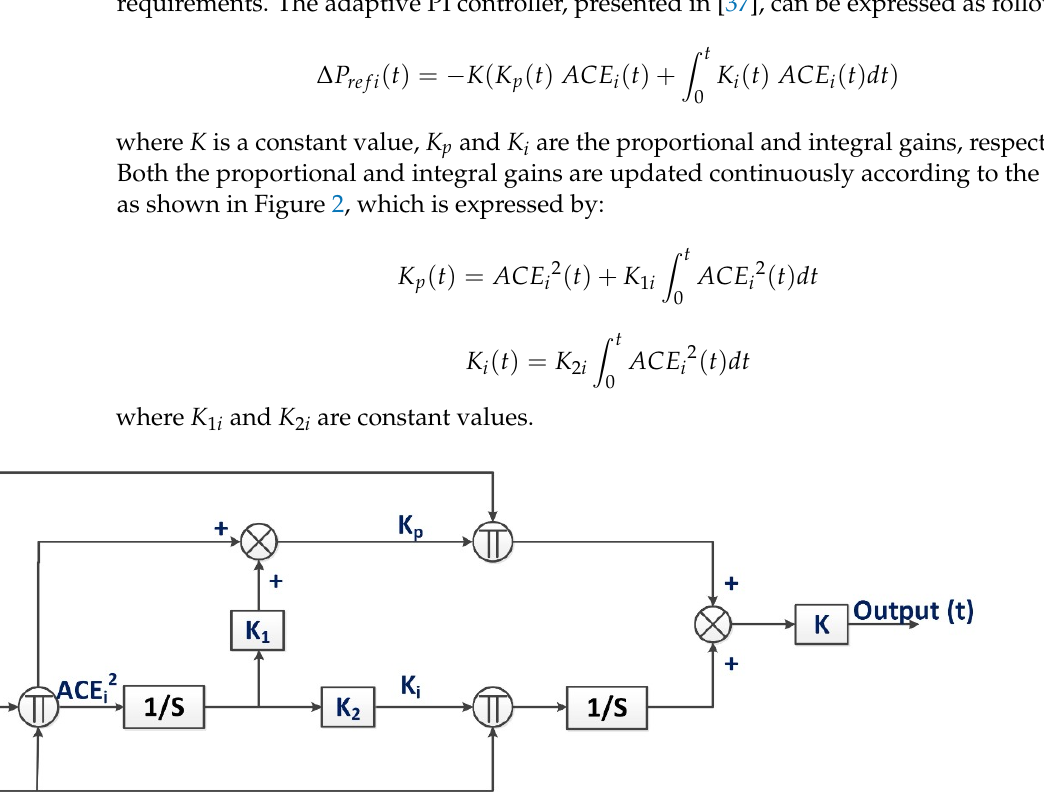
Figure 2. The adaptive PI applied for two area systems.